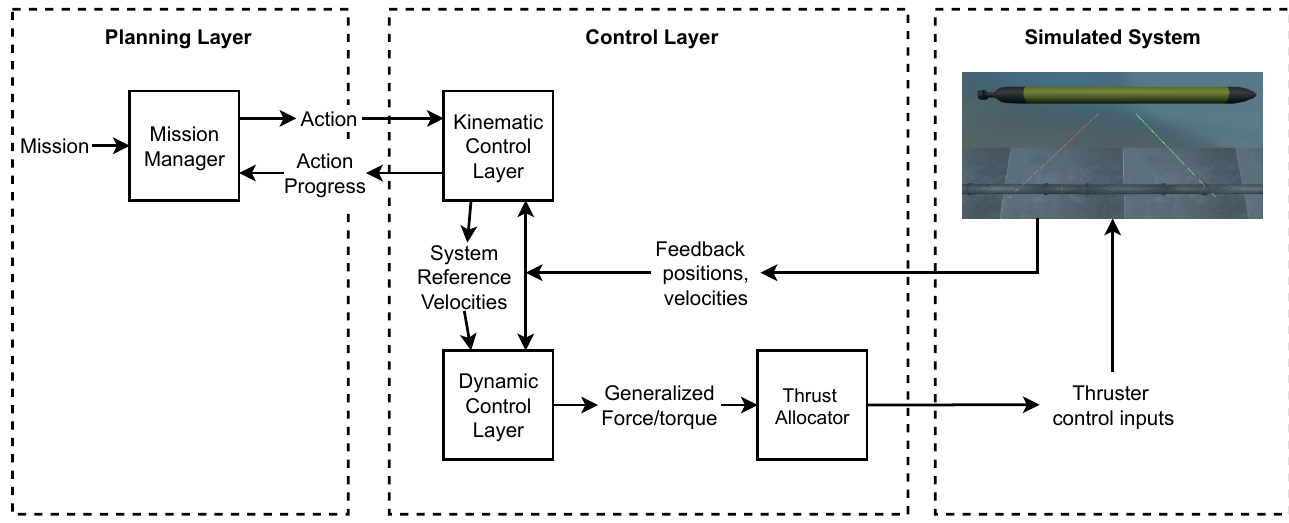
Figure 2. Control architecture depicting the Planning Layer, the Control Layer, and the Simulated